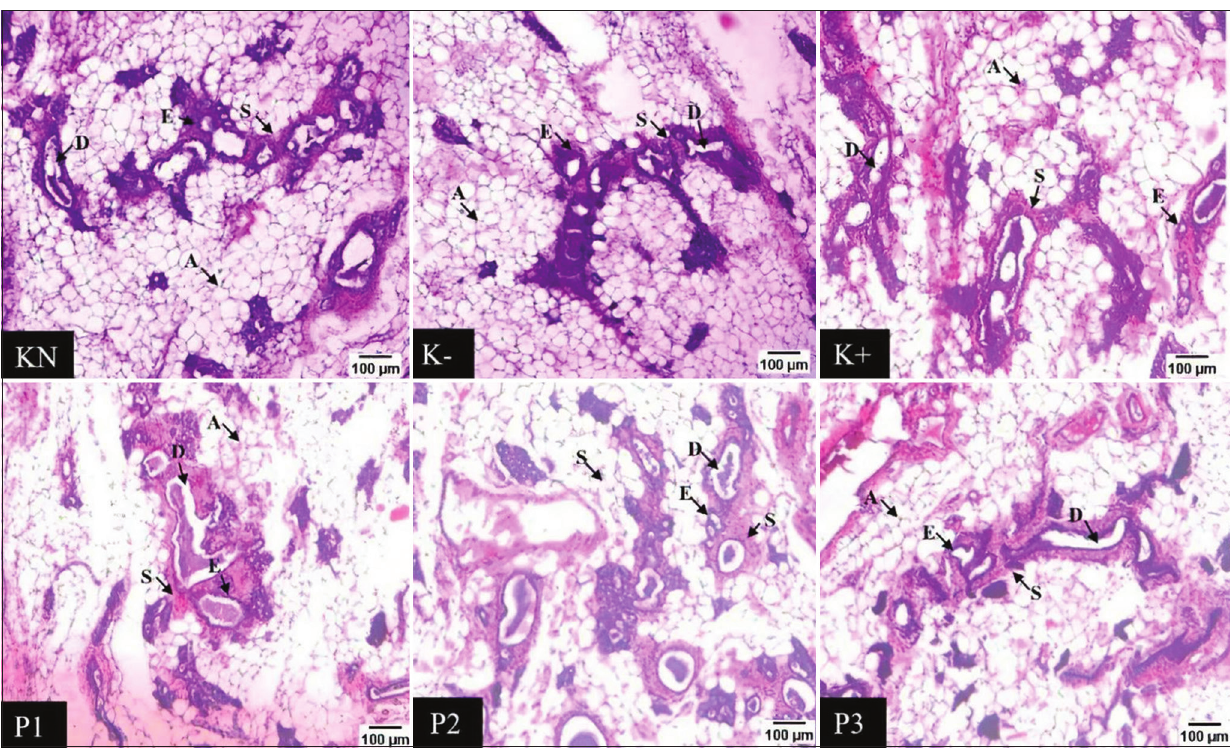
Figure-4: Effect of the ethanolic extract of red okra pods on the mammary gland histology. 100× magnification microscope. The arrows show the differences in mammary gland epithelial tissue. A=fat tissue, D=ducts, E=Epithelial tissue, S=Stroma. KN=Normal control; K−=Negative control, K+=Positive control. P1, P2, and P3=Administrated with 50, 100, and 200 mg/kg body weight ethanolic extract of red okra pods.